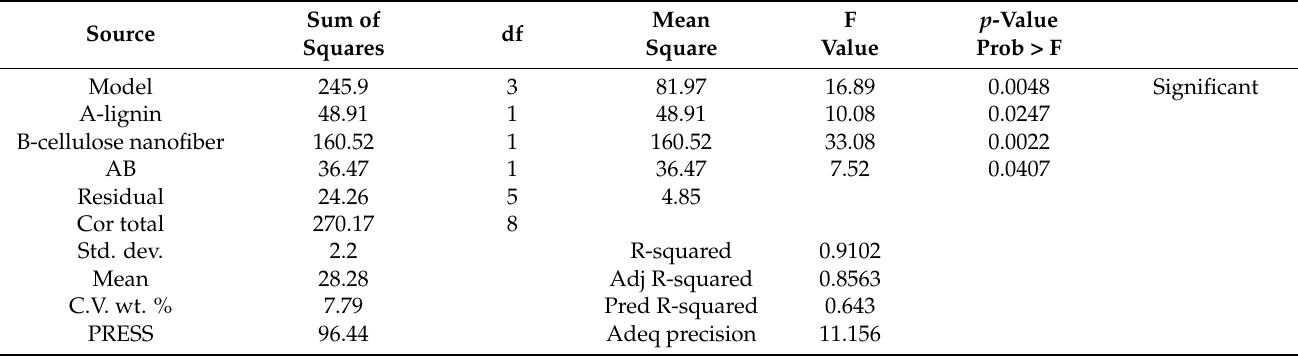
Table 2. ANOVA for response surface quadratic model for MAB of lignin–cellulose nanofiber-filled thermoplastic starch composite